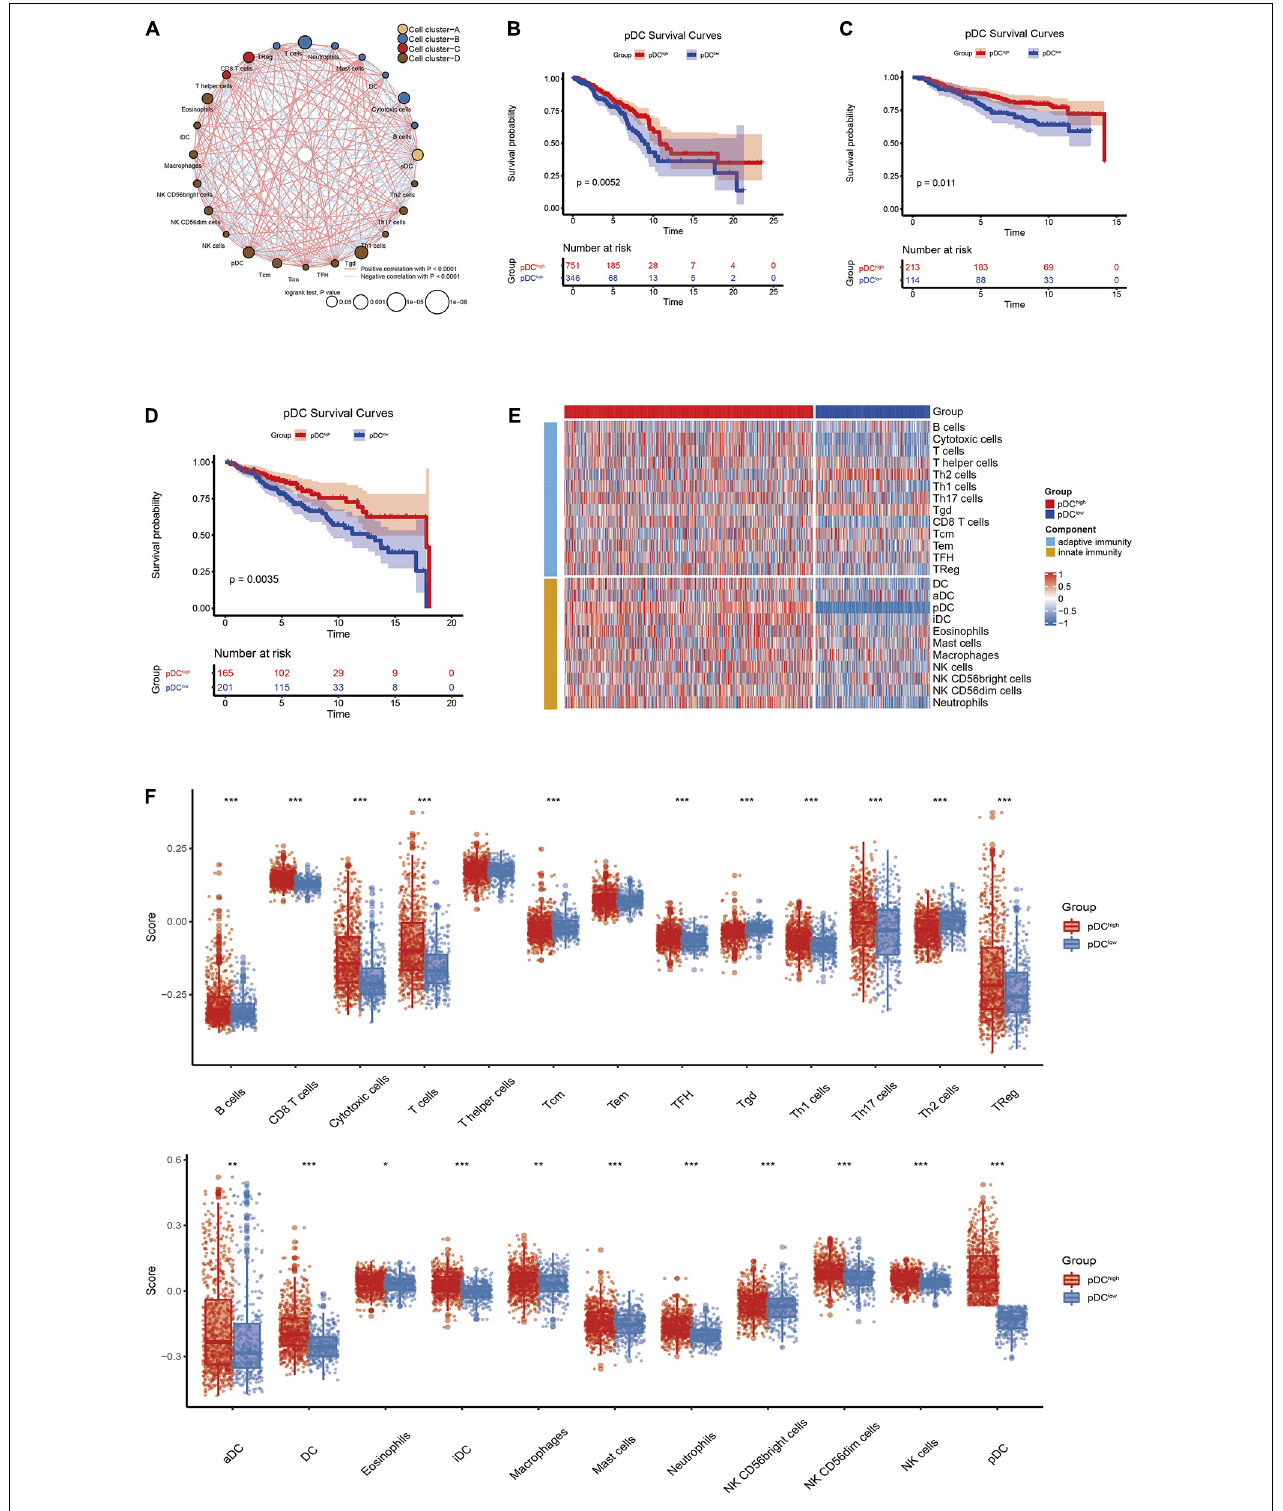
FIGURE 2 | The correlation between clinical outcomes and pDC abundance in BRCA patients. (A) Correlations among immune cell populations. (B–D) Kaplan–Meier curves for the OS of BRCA patients revealed that patients with elevated pDC abundance exhibited favorable clinical outcomes when compared with patients with low pDC abundance in TCGA, GSE20685, and GSE86166 cohorts. (E,F) The immune infiltration levels between the two groups, including adaptive immune signatures and innate immune signatures. The meaning of the statistical difference is as follows: * represents p ≤ 0.05, ** represents p ≤ 0.01, and *** represents p ≤ 0.001.